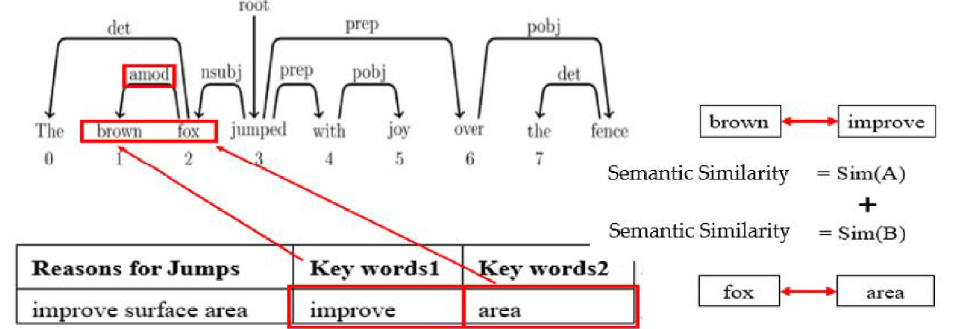
Figure 6. Illustration of the similarity calculation between corresponding text keywords and dictionary keywords.